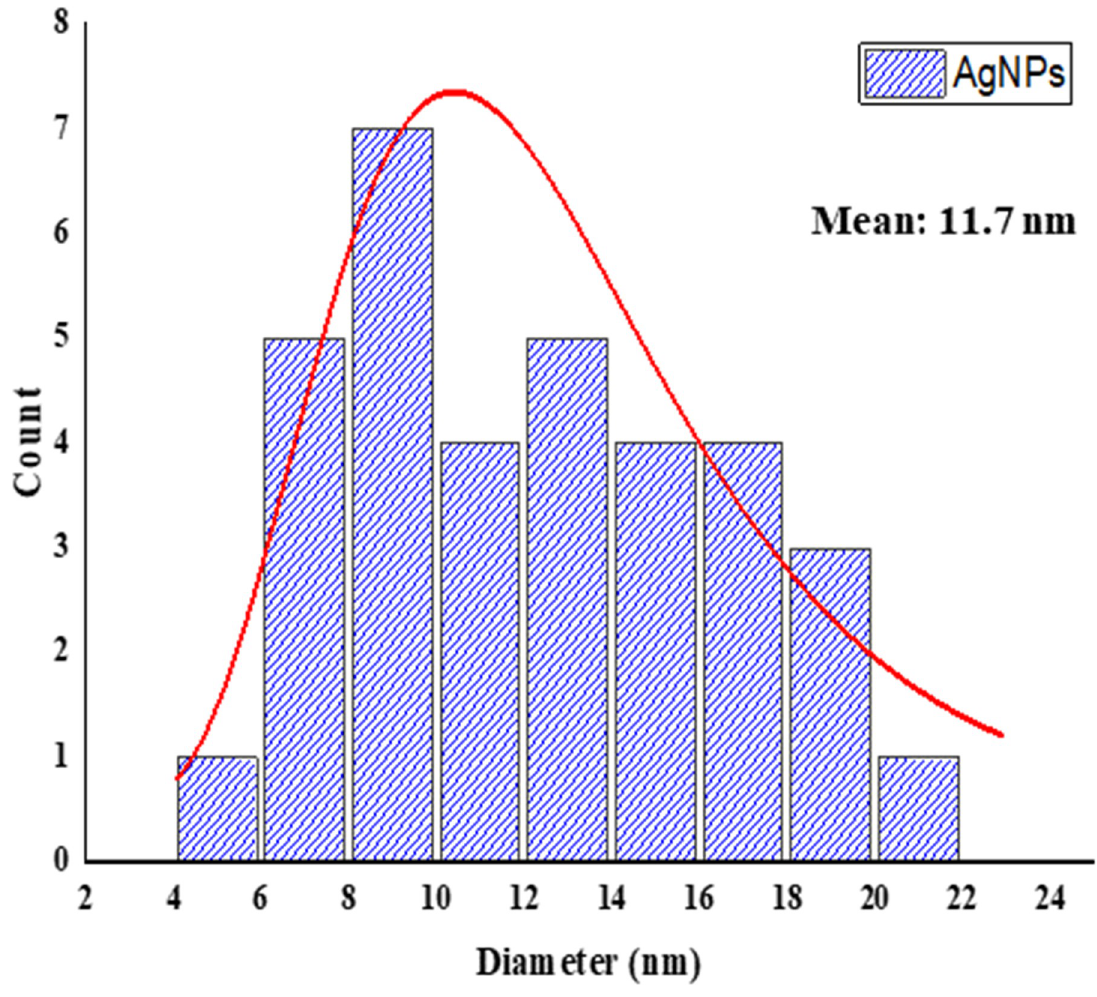
Fig 8. TEM size distribution histogram of